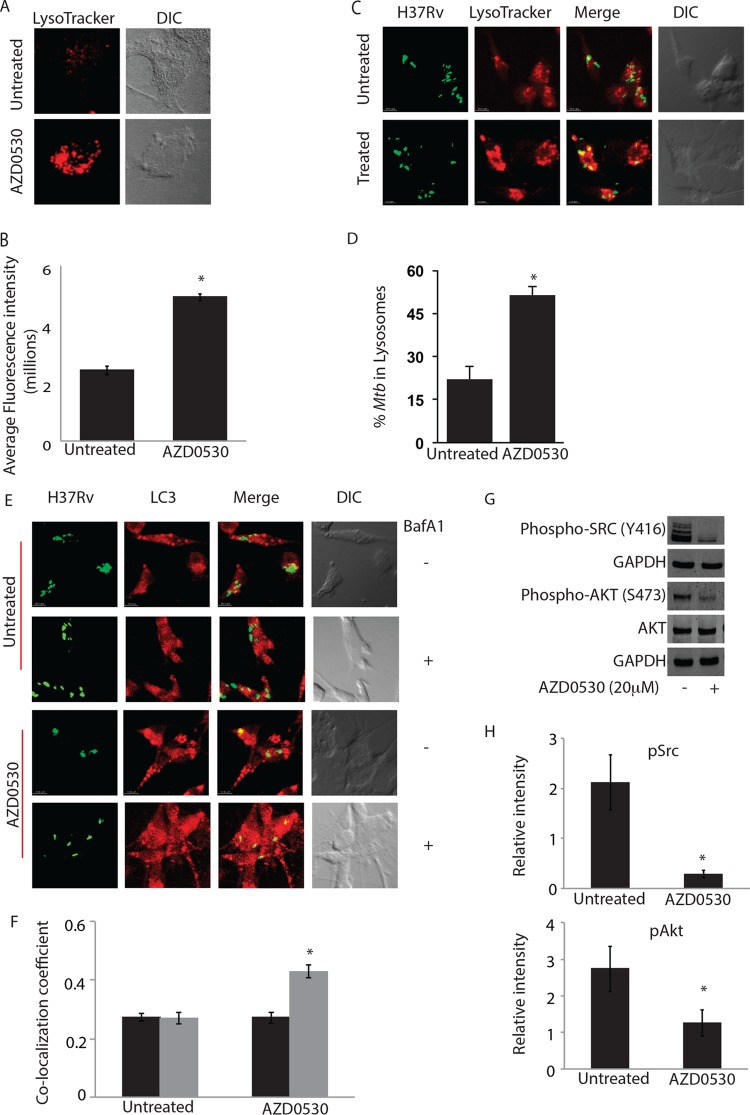
Src inhibition promotes phagosome acidification and autophagy in Mycobacterium tuberculosis-infected macrophages. (A) Uninfected THP-1 cells were treated with 20 µM AZD0530 for 48 h. The number of acidified lysosomes (LysoTracker, red) drastically increased upon treatment. DIC, differential interference contrast. (B) Average LysoTracker intensity per cell was calculated in uninfected untreated or AZD0530-treated THP-1 macrophages. The plot represents data from more than 100 cells across three different fields from two different experiments (values ± standard errors of the means; *, P value < 0.05). (C) H37Rv-infected THP-1 cells were treated with 20 µM AZD0530 for 48 h. Confocal images clearly show an increase in colocalization (merge, yellow regions) of M. tuberculosis (green) and acidified lysosomes (red) upon treatment. (D) Percentage of H37Rv colocalizing with acidified lysosomes upon AZD0530 treatment (20 µM, 48 h) is depicted as bar plots (average ± standard deviation; *, P value < 0.001). (E) PKH67-labeled H37Rv-infected THP-1 cells were left untreated or treated with 20 µM AZD0530 for 48 h. For the final 3 h, cells from both sets were either treated with BafA1 or left untreated to assess autophagy flux. Cells were fixed and stained using anti-LC3 antibody. (F) Colocalization coefficient (M1) of H37Rv with LC3 in AZD0530-treated and untreated sets in the presence or absence of BafA1 was calculated. The plot represents data from more than 100 cells across three fields from two different experiments (values ± standard errors of the means; *, P value < 0.01). (G) Western blots showing levels of indicated proteins in H37Rv-infected THP-1 cells, with or without AZD0530 treatment (20 µM), after 48 h of infection. GAPDH, glyceraldehyde-3-phosphate dehydrogenase. (H) Western blot intensities were estimated using Odyssey software. Values were normalized to the loading control and plotted as relative intensity of uninfected and untreated control set (values ± standard errors of the means; *, P value < 0.05).